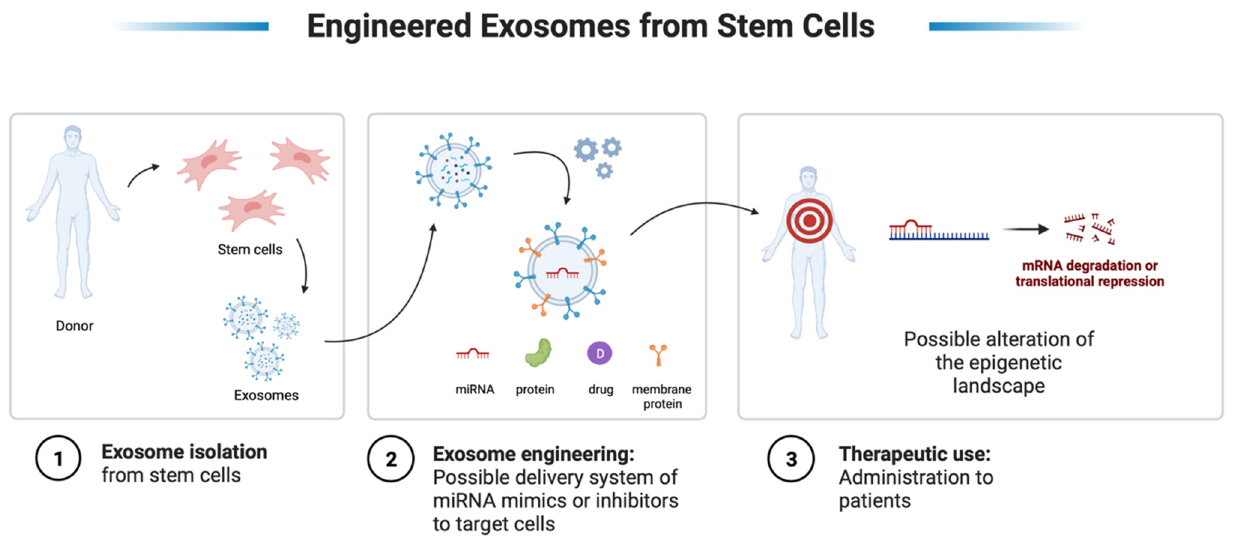
Figure 3. Representation of a possible therapeutic strategy for stem cell-derived exosomes. Created with BioRender.com.